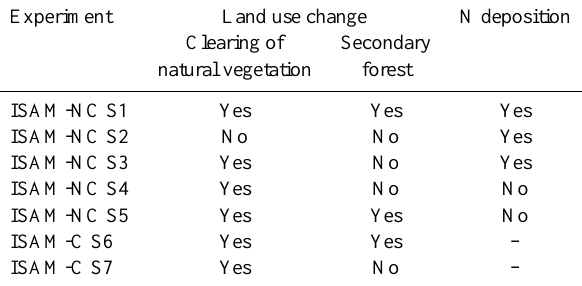
Table 1. Experiments performed for the period 1765–2000 for ISAM-NC and ISAM-C. The change of climate and atmospheric CO 2 concentrations are considered in all